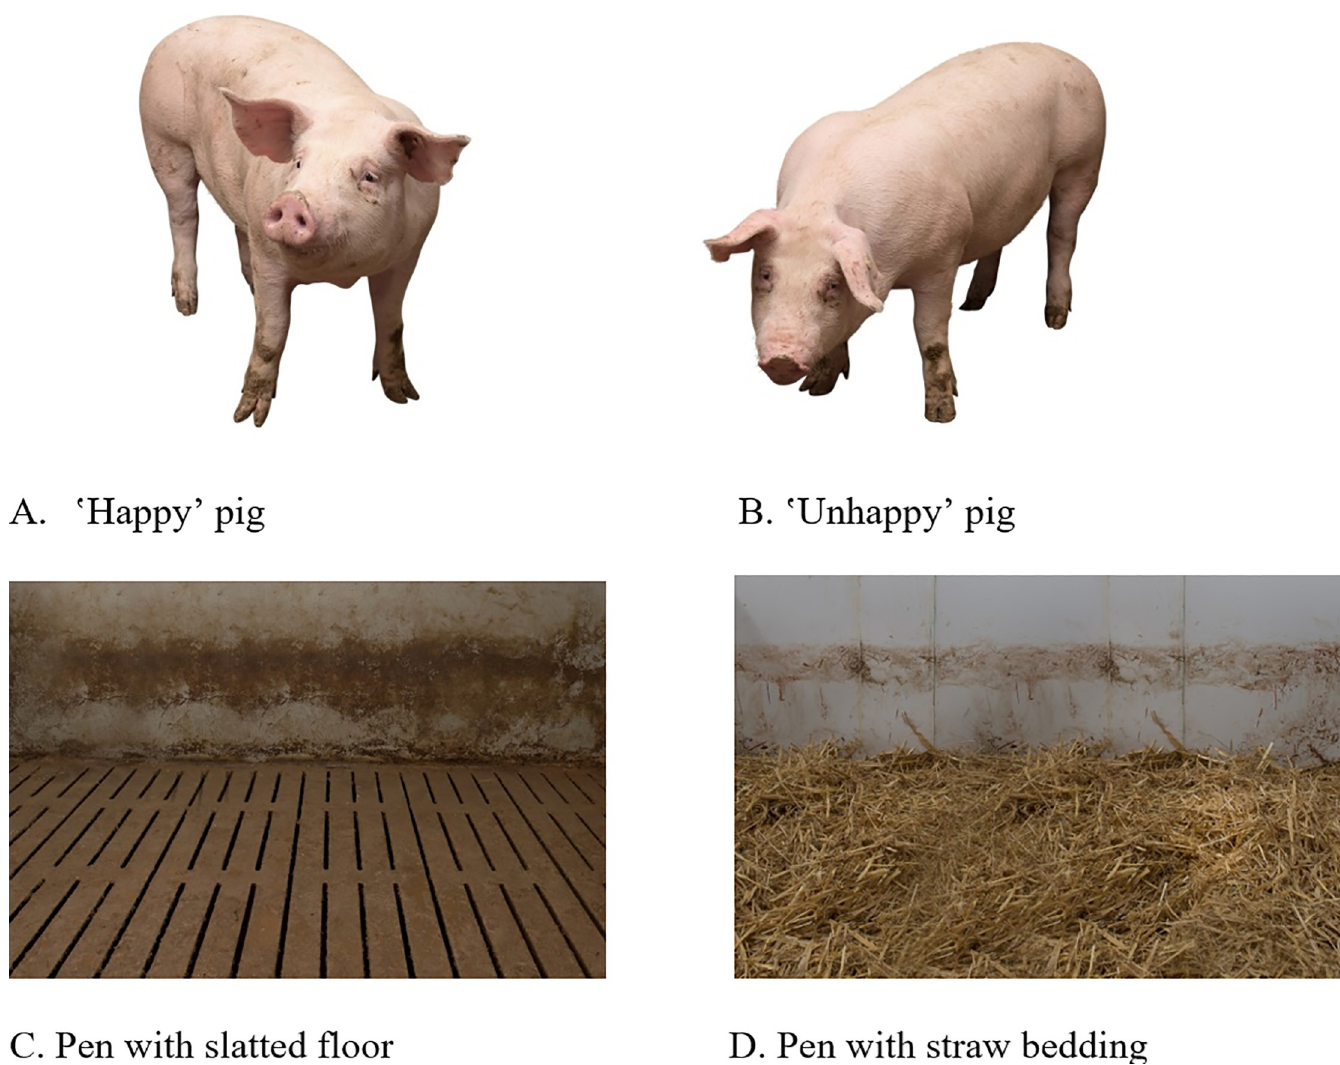
Fig 2. Pictures of pigs and pens presented as stimuli to survey participants. Source: Landpixel (Swen